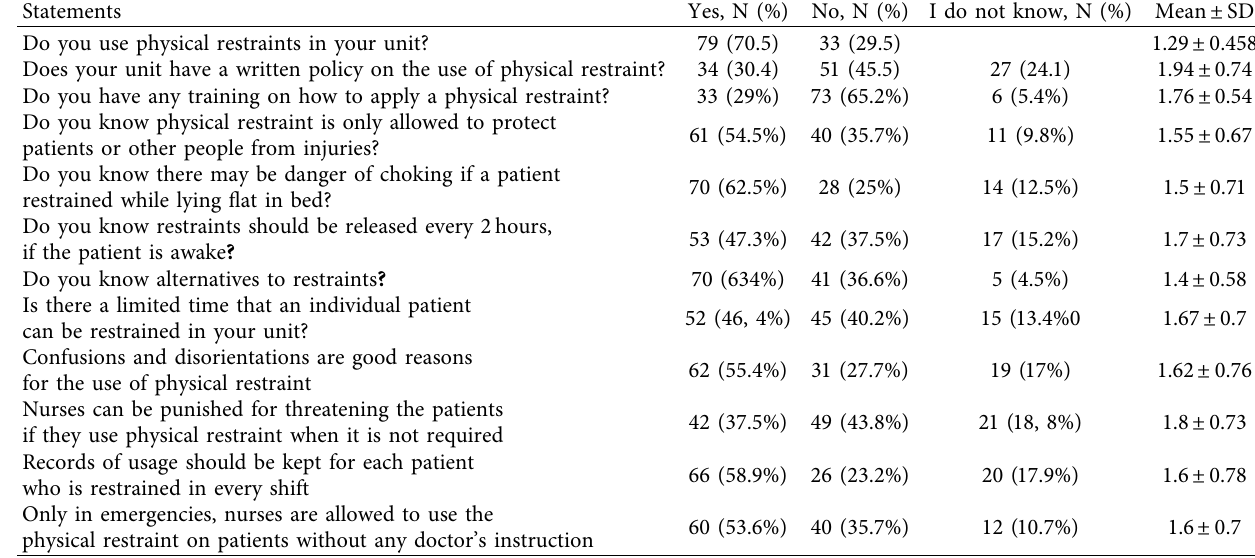
Table 2: Selected items measuring participant nurses’ knowledge regarding physical restraint use at federally administered hospitals in Addis Ababa, 2019 ( n �